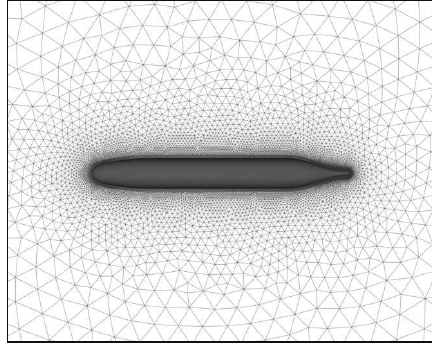
Figure 5: SUBOFF bare hull and viscous mesh.